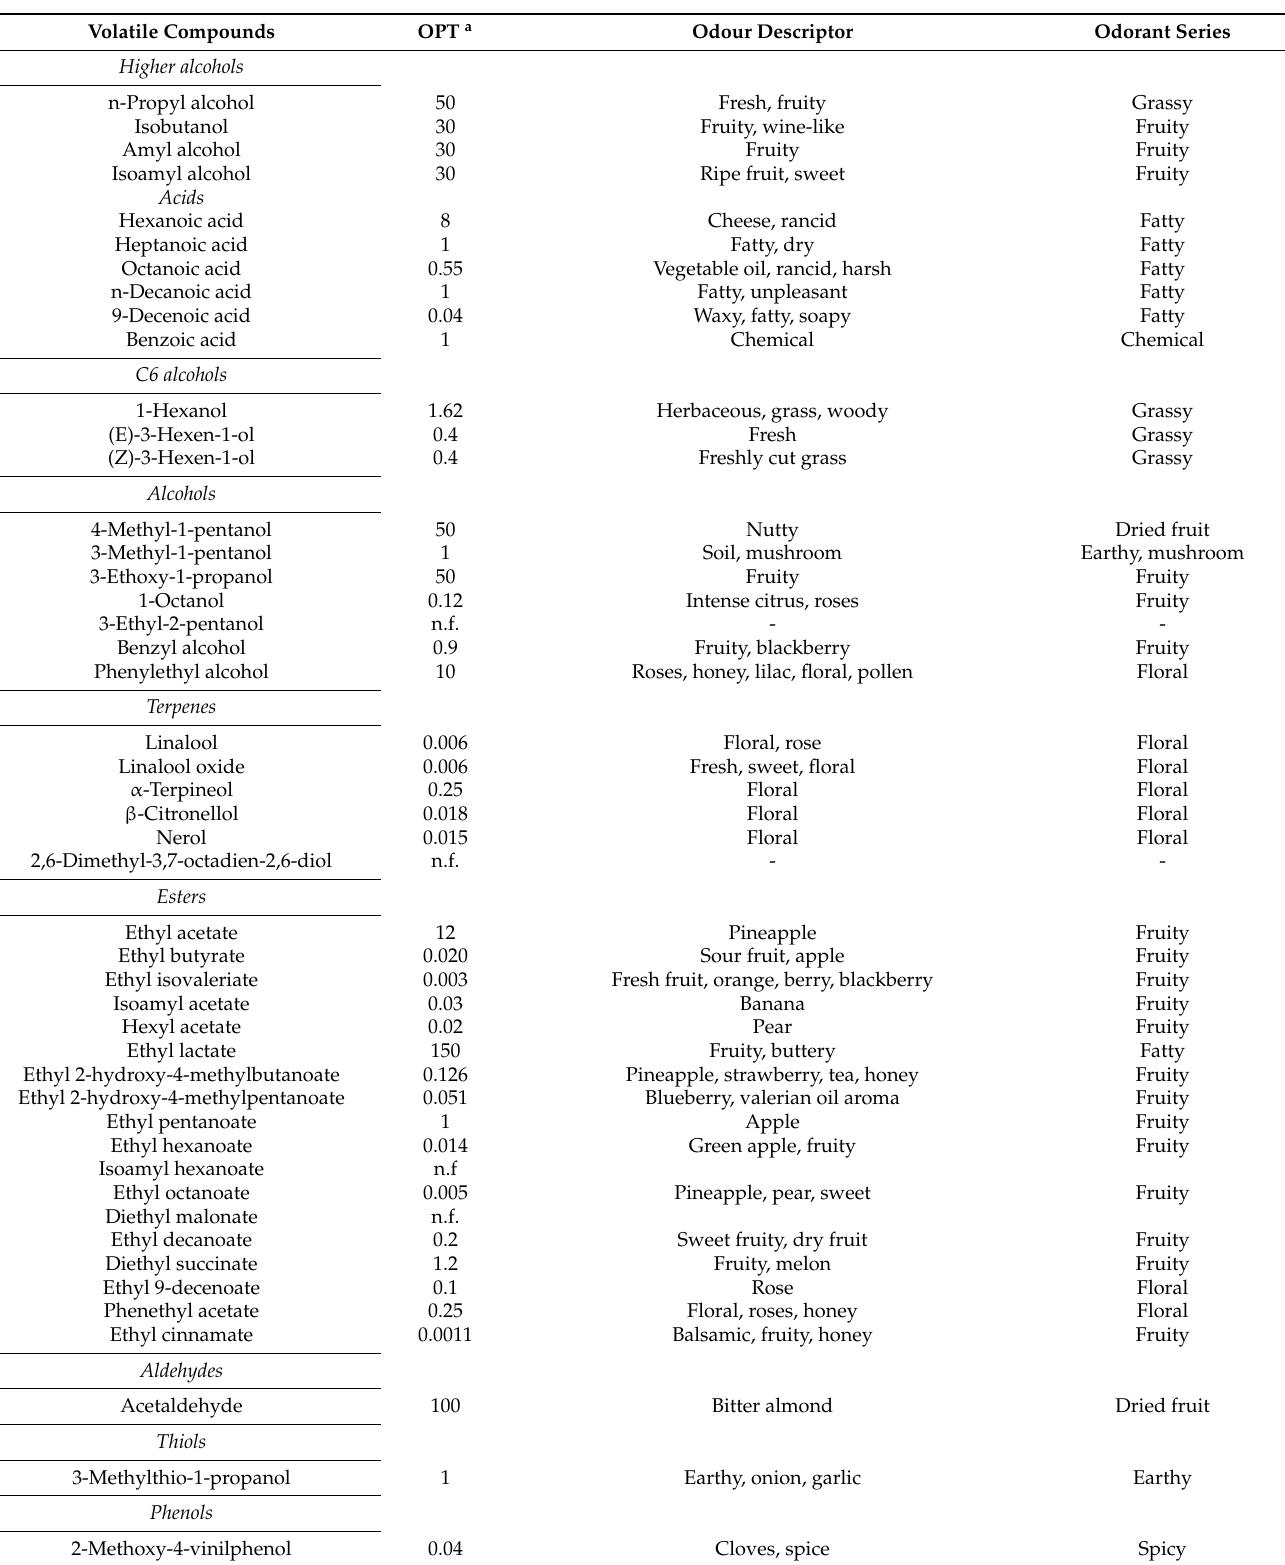
Table 3. Odour perception threshold (OPT), odour descriptors and odorant series of the volatile compounds found in Palomino